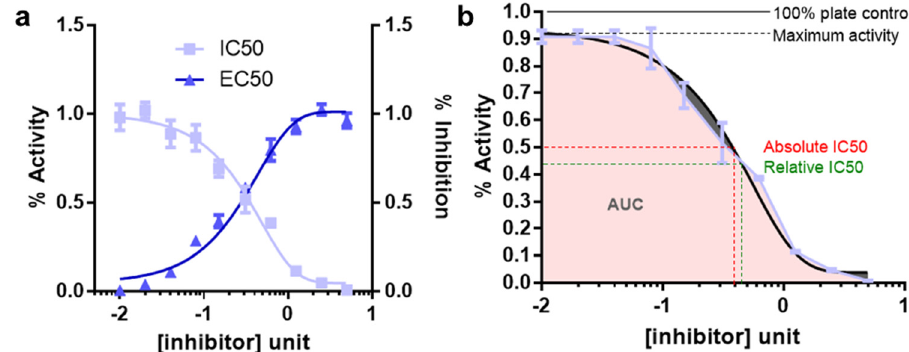
Figure 3. IC50, EC50 and AUC measurements from dose response plots. ( a ) Dose response plots for AC50 (dark blue) and IC50 (light blue). ( b ) AUC calculation of a dose response plot. The figure also represents the theoretical (red) and relative/tested (green) IC50 measurements from the dose response curves. The theoretical (solid black line) activity represented as plate control and maximum activity tested (broken black line) can also be different.